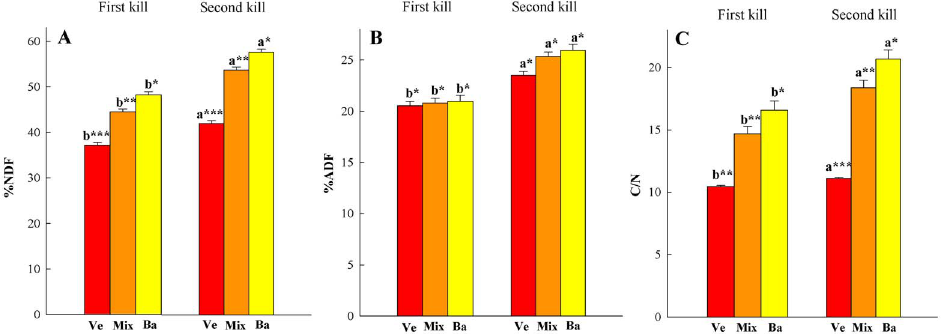
Figure 4. Neutral detergent fiber-NDF- (A) and acid detergent fiber -ADF- (B) fractions, and C/N ratio (C) in vetch (Ve), barley (Ba) and the mixture (Mix), measured for the first and second kill dates. Values are the mean of two cropping seasons. Letters above bars show significant differences between kill dates for each species, and asterisks between species for each kill date. Small bars represent the standard error.